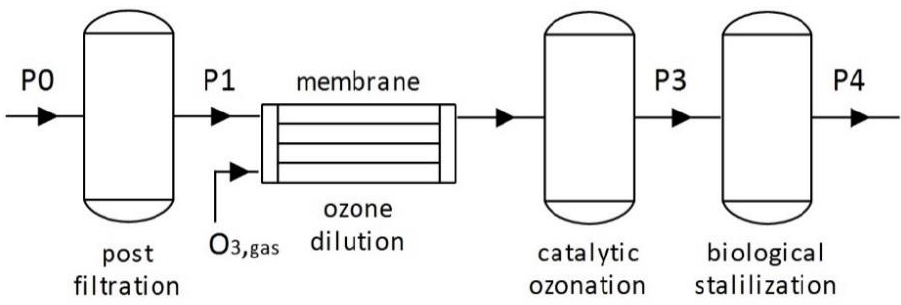
Figure 1. Flowchart of the pre-industrial level unit .